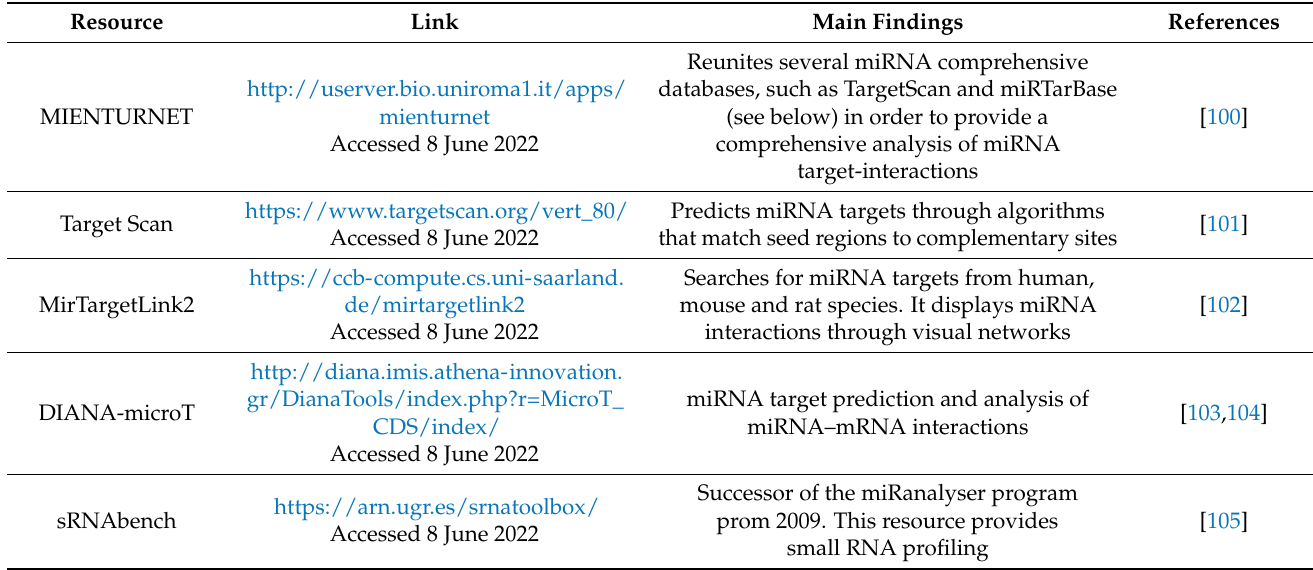
Table 3. Algorithms and tools for identifying miRNAs and their target. Resource Link Main